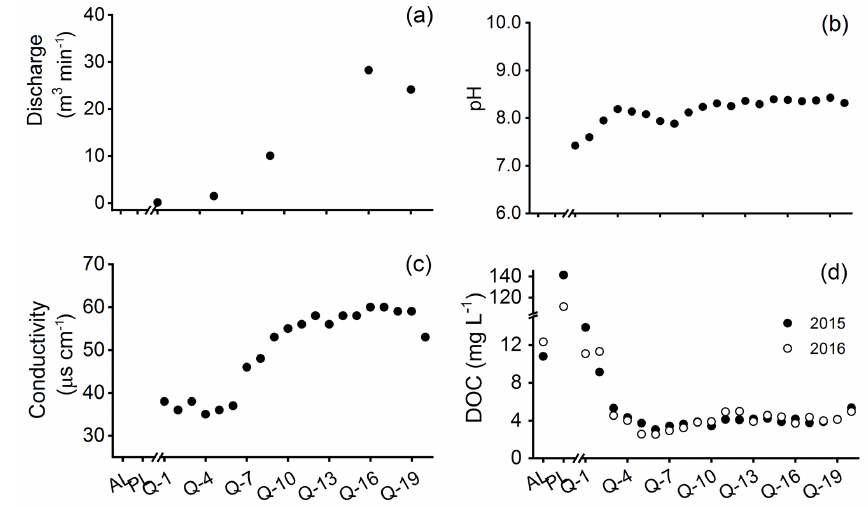
Figure 2. (a) Stream water discharge, (b) pH and (c) conductivity at the sampling sites in 2015; and (d) DOC concentration in stream water and PL and AL leachates collected in 2015 (filled circles) and 2016 (open circles).